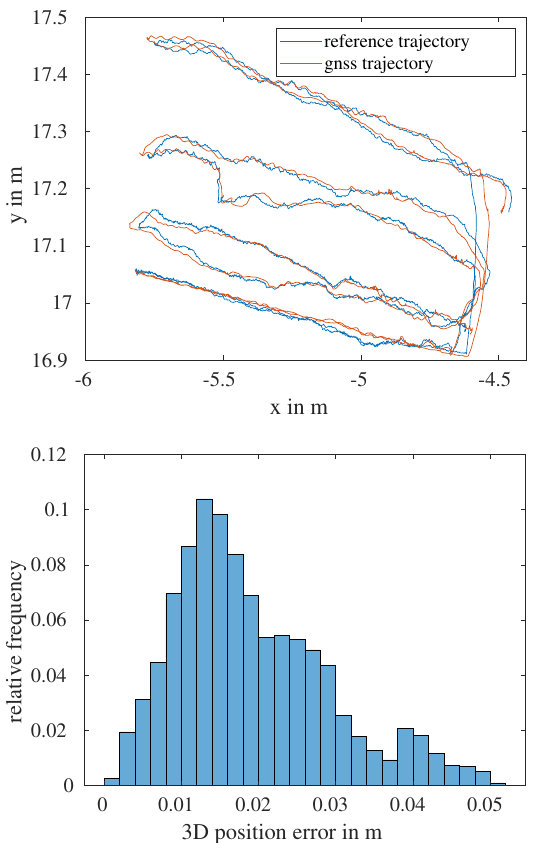
Figure 5. Example of estimated GNSS trajectory compared to reference trajectory acquired using an optical tracking system. Top: Plot of the trajectory, Bottom: Histogram of the 3D position error between the two